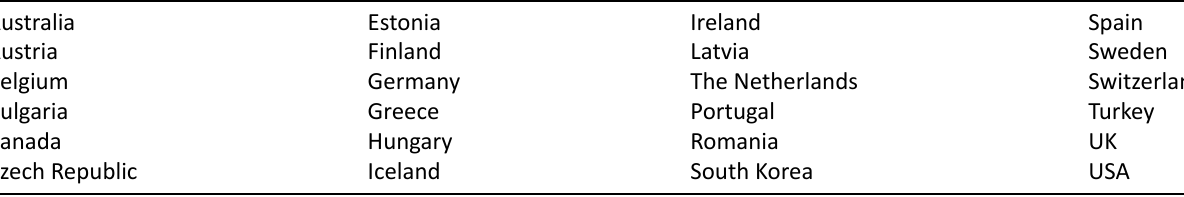
Table 1. Countries under